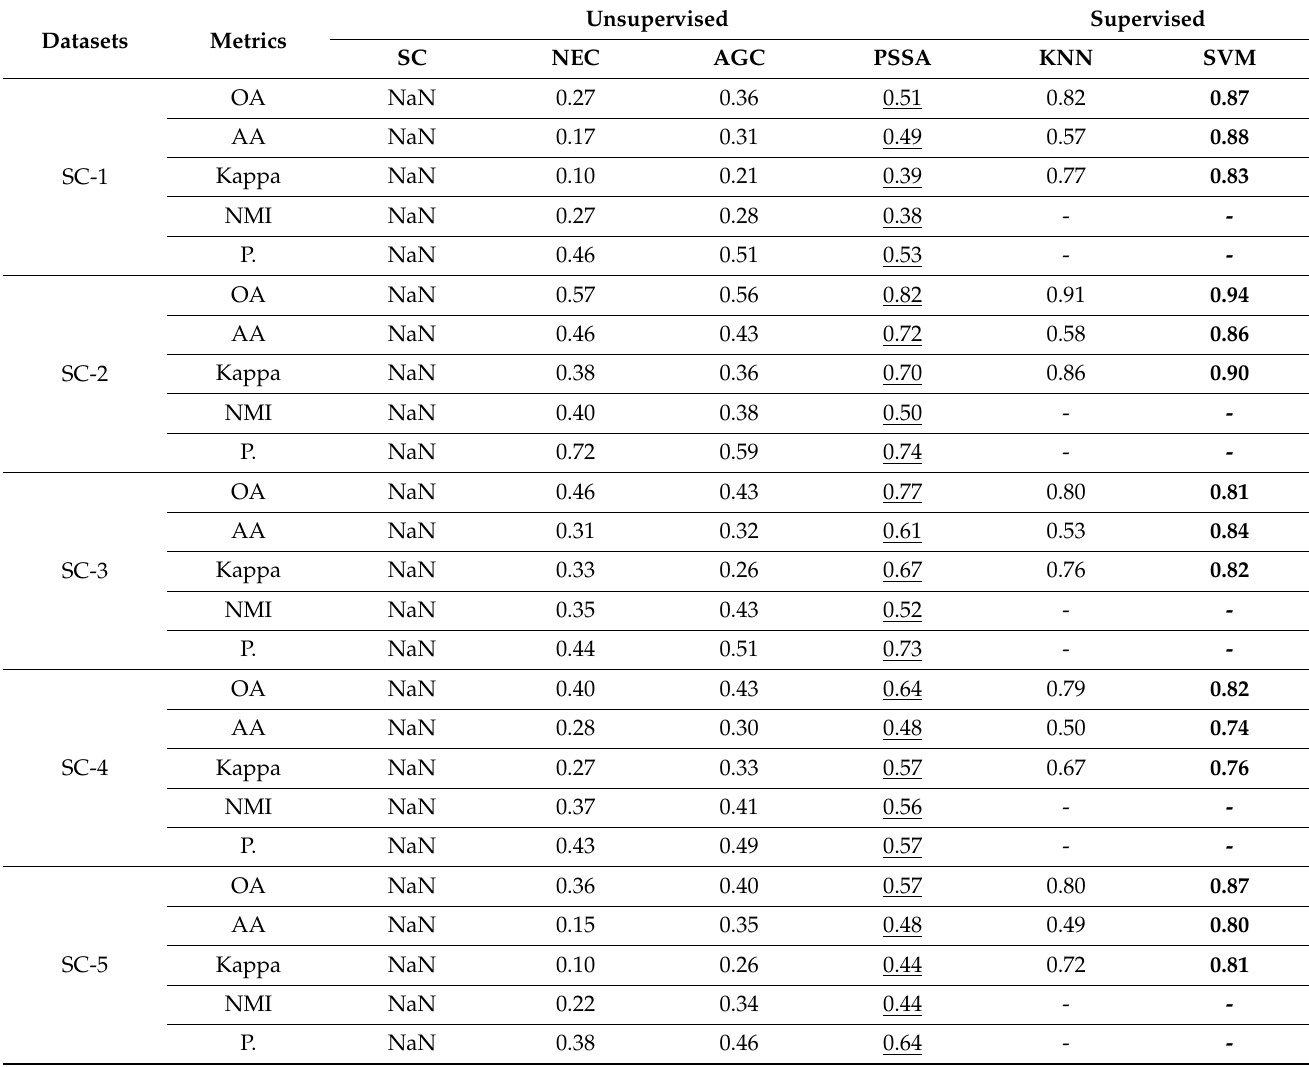
Table 3. Clustering results on five self-collected datasets, where “NaN” represents no available results due to out of memory, and “-” denotes no referred results. Bold represents the best result of all methods and underline represents the best result of unsupervised